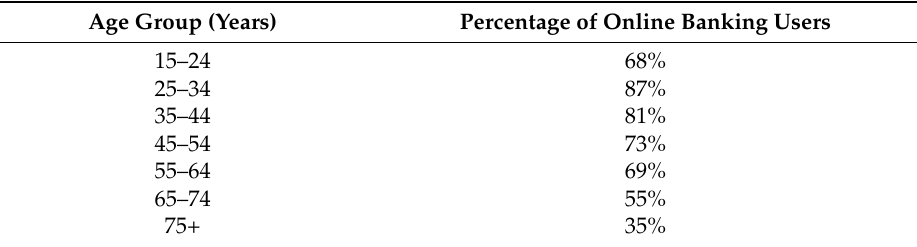
Table 2. Age group distribution of the percentage of online banking users in New Zealand. Source: